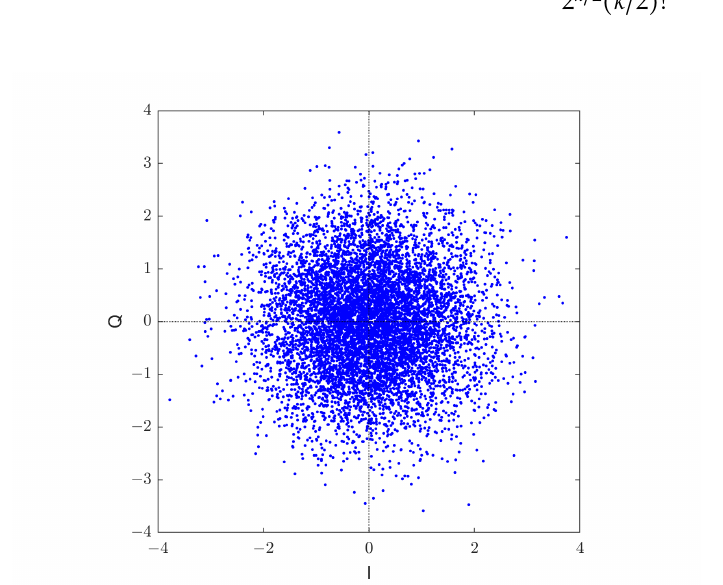
Figure 6. A collection of signal constellations of noise-free transmitted GDSS signal.